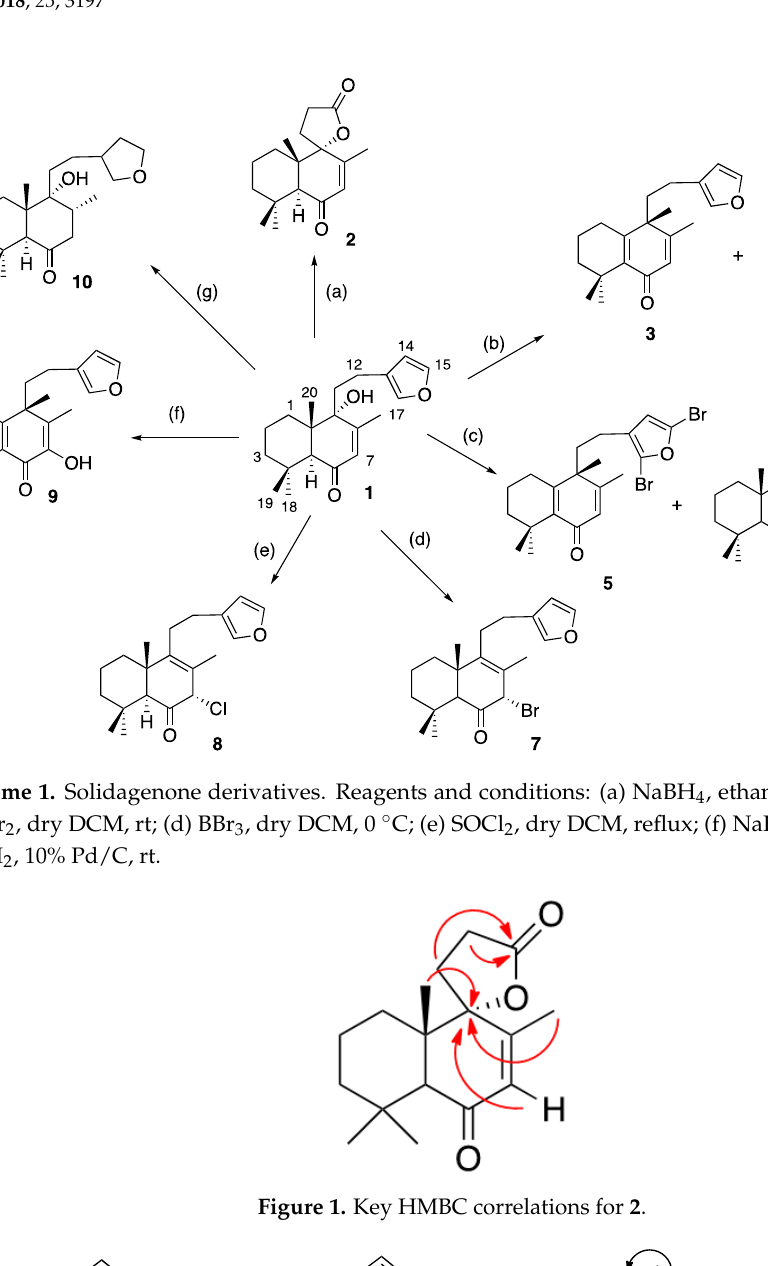
Figure 1. Key HMBC correlations for 2.